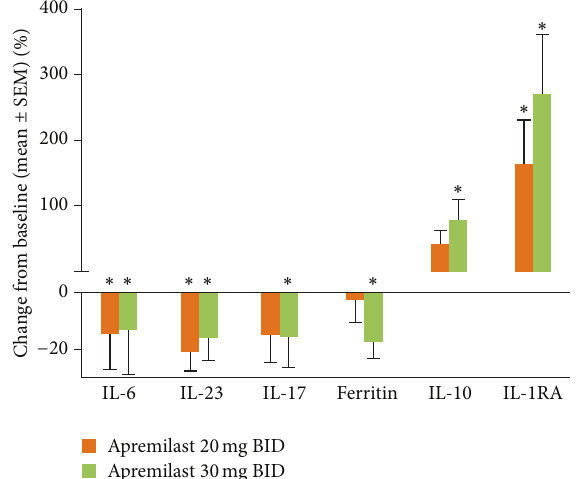
Figure 3: Mean percent change in biomarkers with apremilast 20 mg BID and apremilast 30 mg BID at Week 40; no patients were receivingplaceboatthistimepoint. ∗ 𝑃 < 0.05 Wilcoxonsignedrank test (two-sided 𝑃 value for testing the median of